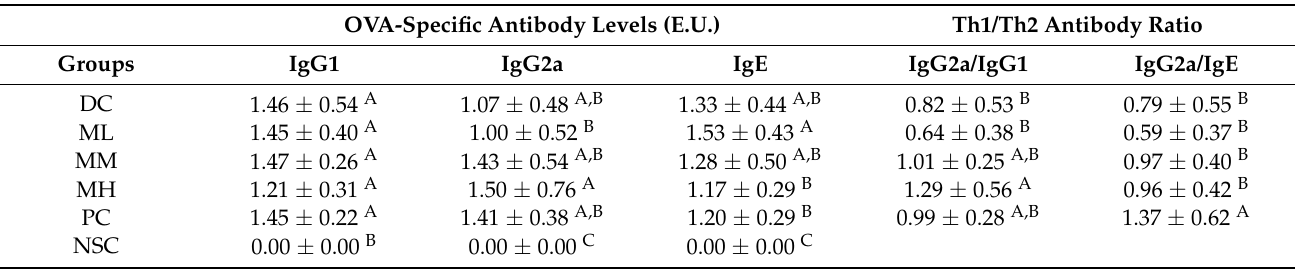
Table 5. Effects of menthone inhalation with different doses of serum OVA-specific IgG1, IgG2a, and IgE antibody titers of OVA/Al-sensitized and challenged BALB/c asthmatic mice. OVA-Specific Antibody Levels